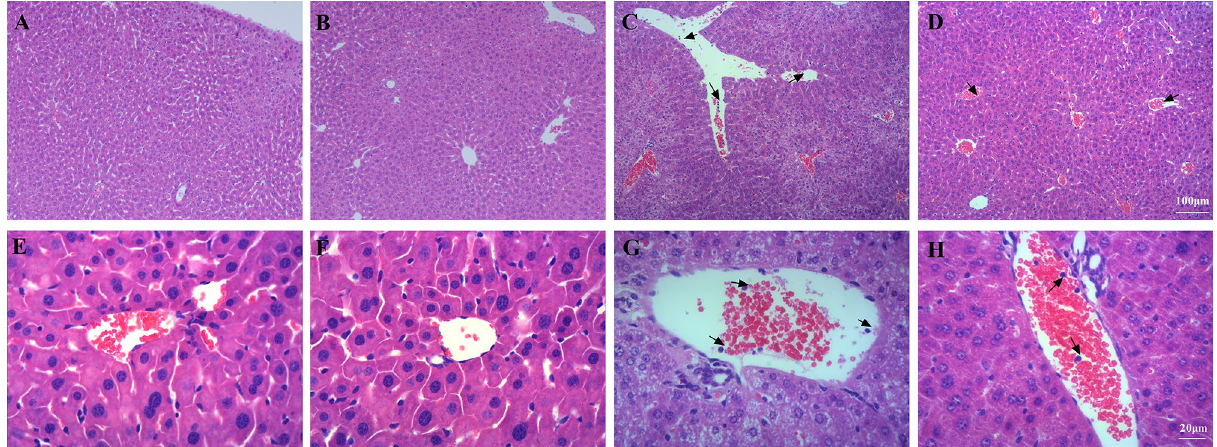
Figure 4. A photomicrograph of liver tissues used for morphological analysis. ( A ) Con group, ( B ) LPS group, ( C ) Ex group, ( D ) Ex + LPS group. White arrows indicate neutrophils [( A – D) × 100 magnification; ( E – H ) × 400 magnification].